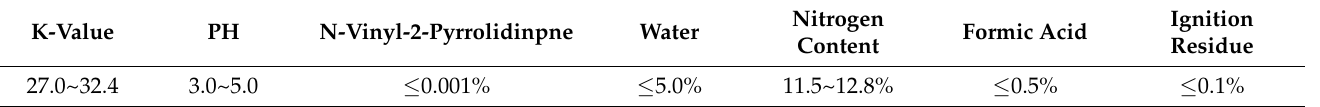
Table 3. PVP Parameters.